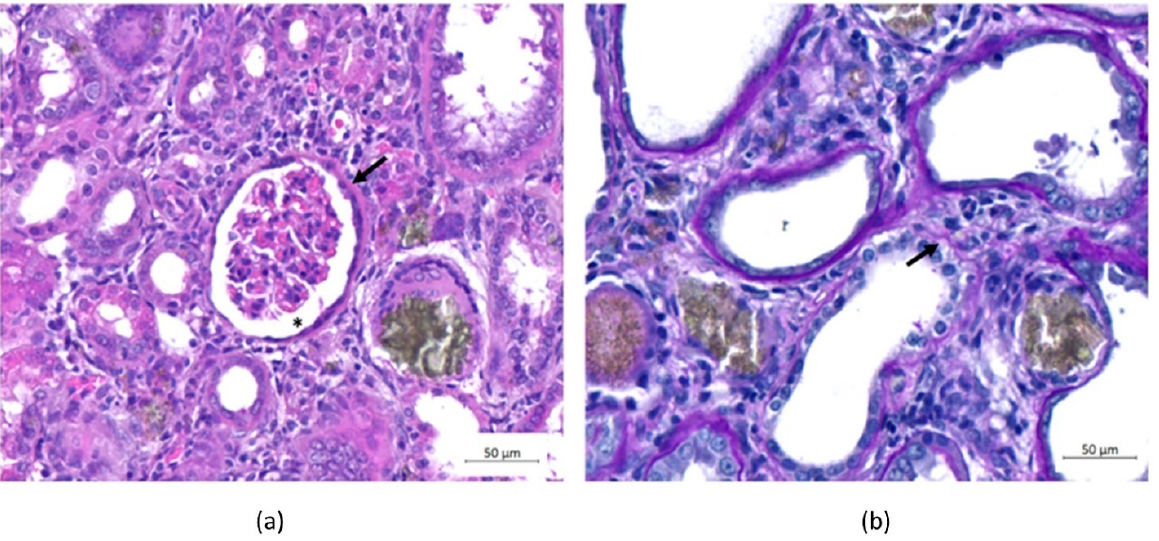
Figure 5. Histopathological evaluation of the kidneys. ( a ) Hematoxylin and eosin (H&E) staining and ( b ) Schiff’s periodic acid (PAS) staining. ( a ) The animals were evaluated on Day 30, and an increase in Bowman’s capsule thickness (arrow) and capsular space hypertrophy (asterisk) was observed in all groups. ( b ) Discontinuity of the basal blade (arrow) was observed in all groups. Scale bar: 50 µm.